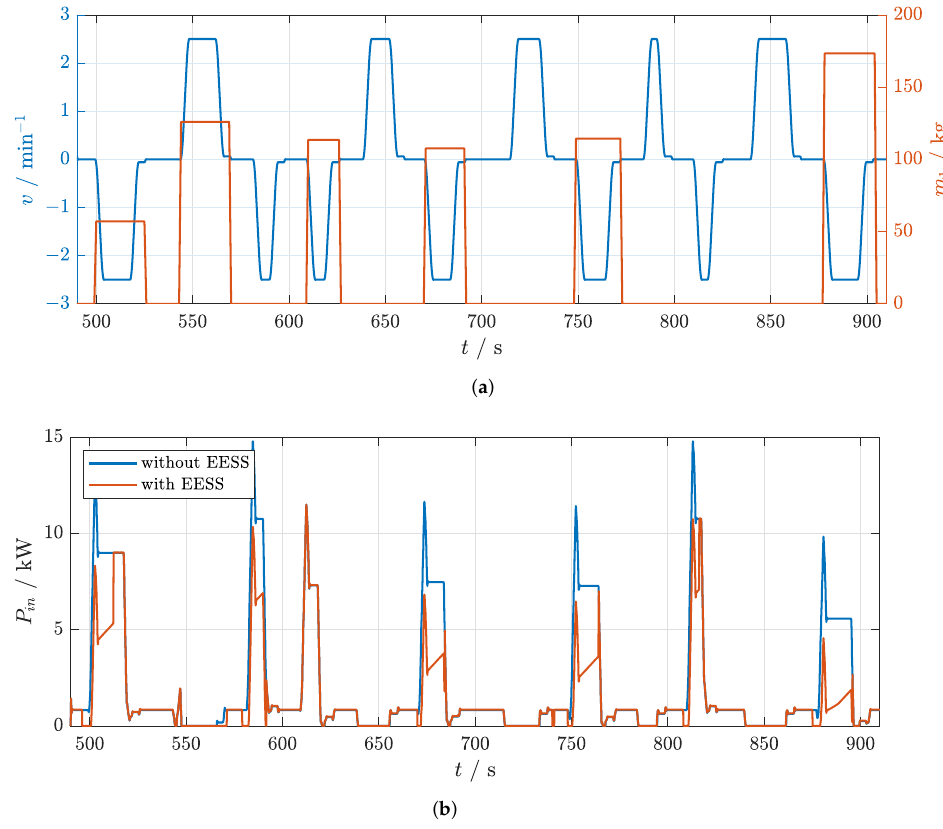
Figure 15. Simulation results for real traffic data. ( a ) Elevator speed setpoint and mass of the load. ( b ) Input